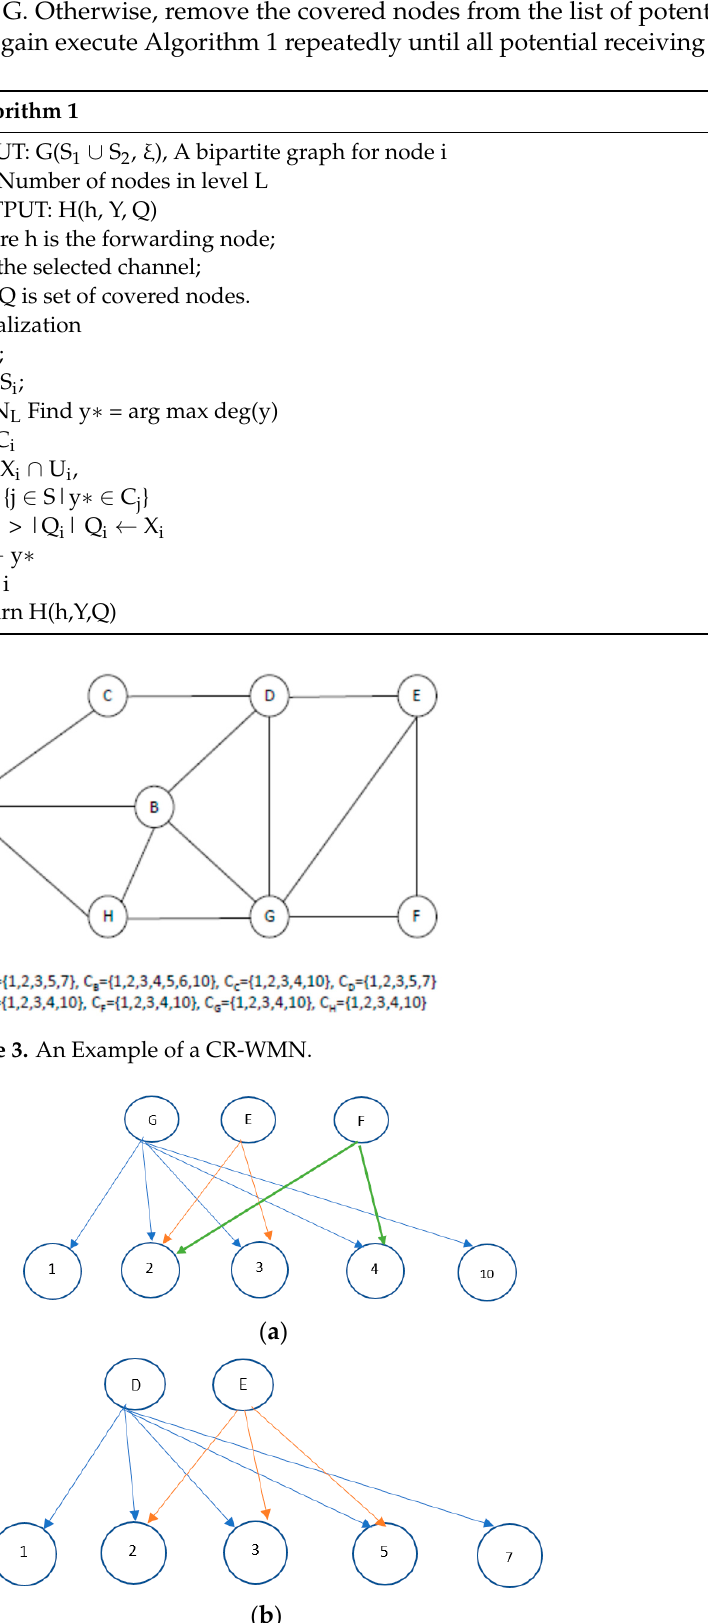
Figure 4. Bipartite graph for nodes G and D. ( a ) A bipartite graph for node G. ( b ) A bipartite graph for node D.